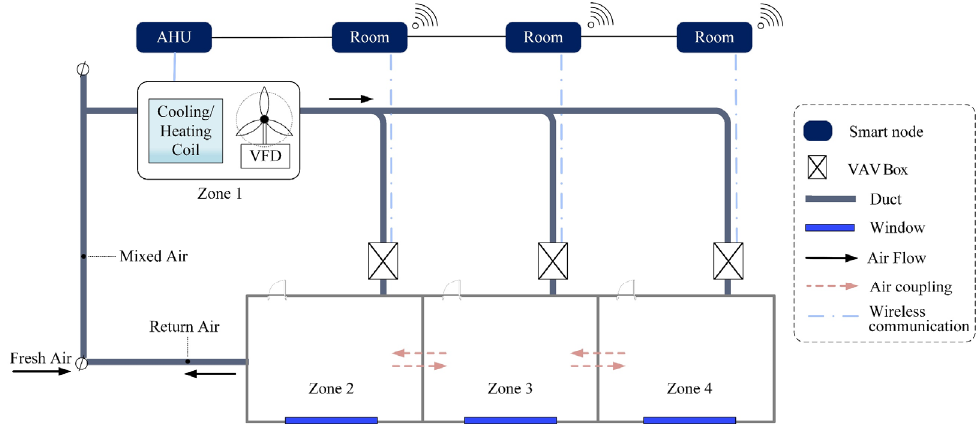
Figure 2. Schematic diagram of the VAV air conditioning system.